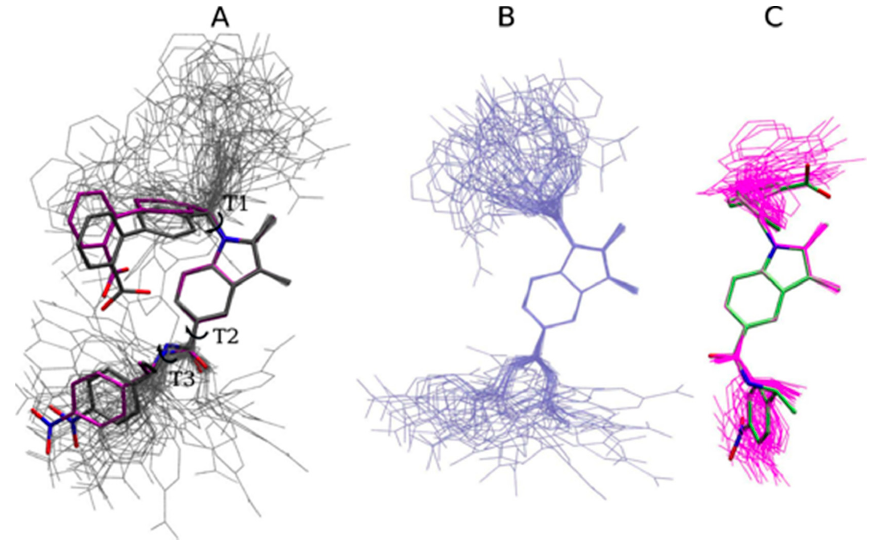
Figure 5. ( A ) SR1664 structures minimized at the MP2 level (carbon atoms in gray) and classically minimized (carbon atoms in purple), superposed with molecular snapshots of MD simulations in vacuum (thin gray lines); ( B ) molecular snapshots of MD simulations in water (thin light blue lines) and ( C ) molecular snapshots of MD simulations of PPAR γ LBD (thin magenta lines) superposed with the crystallographic structure (carbon atoms in lime).